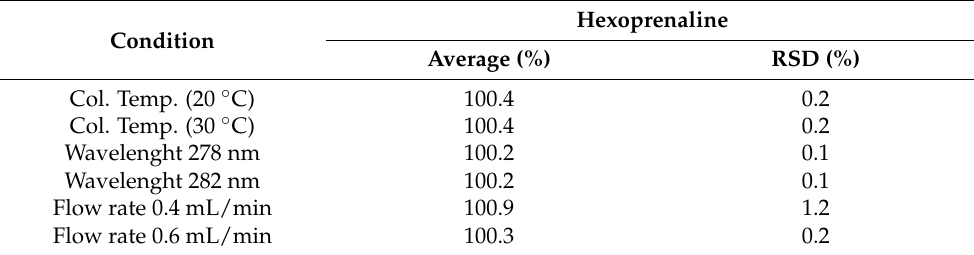
Table 7. Robustness results from method